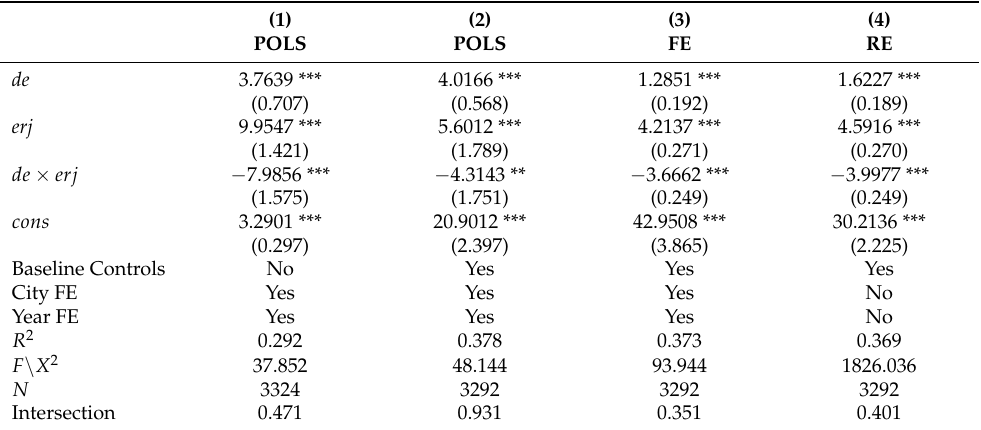
Table 7. Comprehensive analysis of energy input and allocation efficiency I.